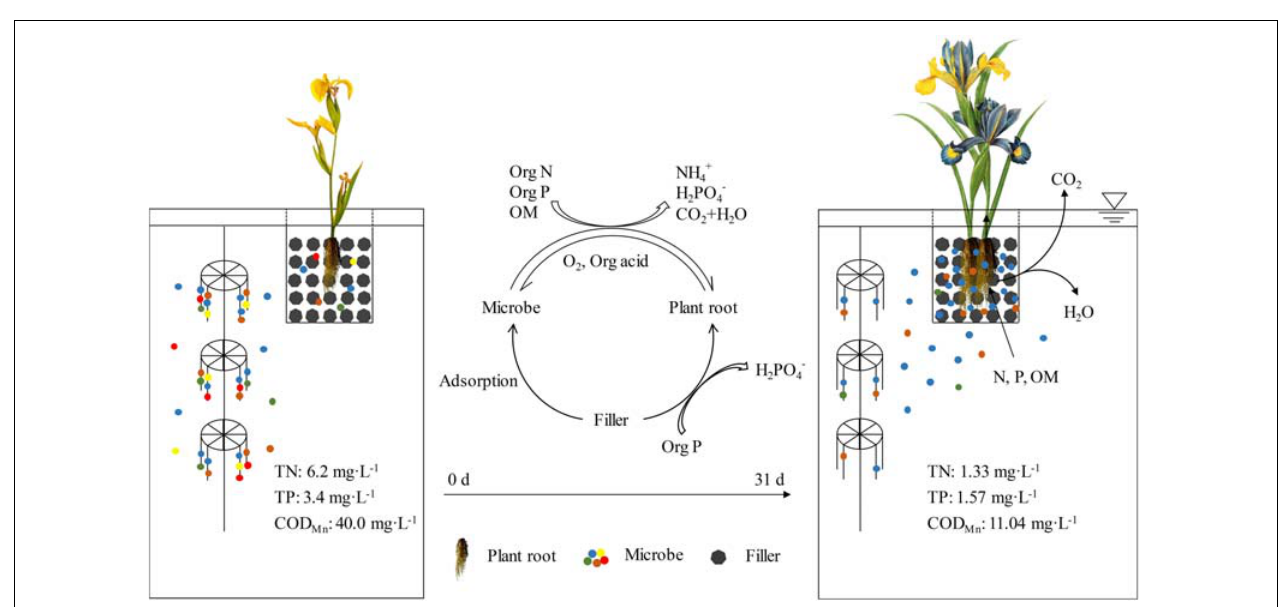
FIGURE 4 | Mechanism of synergistically purifying eutrophic brackish water by plants, microbes, and fillers. Microorganisms can degrade the macromolecules into micromolecules that can be directly absorbed and utilized by plants. Plant roots and fillers provide carriers for attachment and habitation of the functional bacteria. Plant roots can also secrete a variety of unstable carbon compounds, such as organic acids and amino acids that promote microbial metabolism and form biofilms on the root surface.